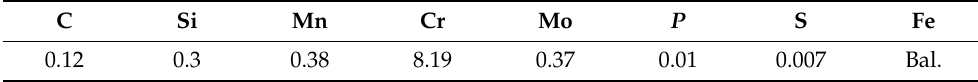
Table 2. Chemical compositions of P91 (wt.%).